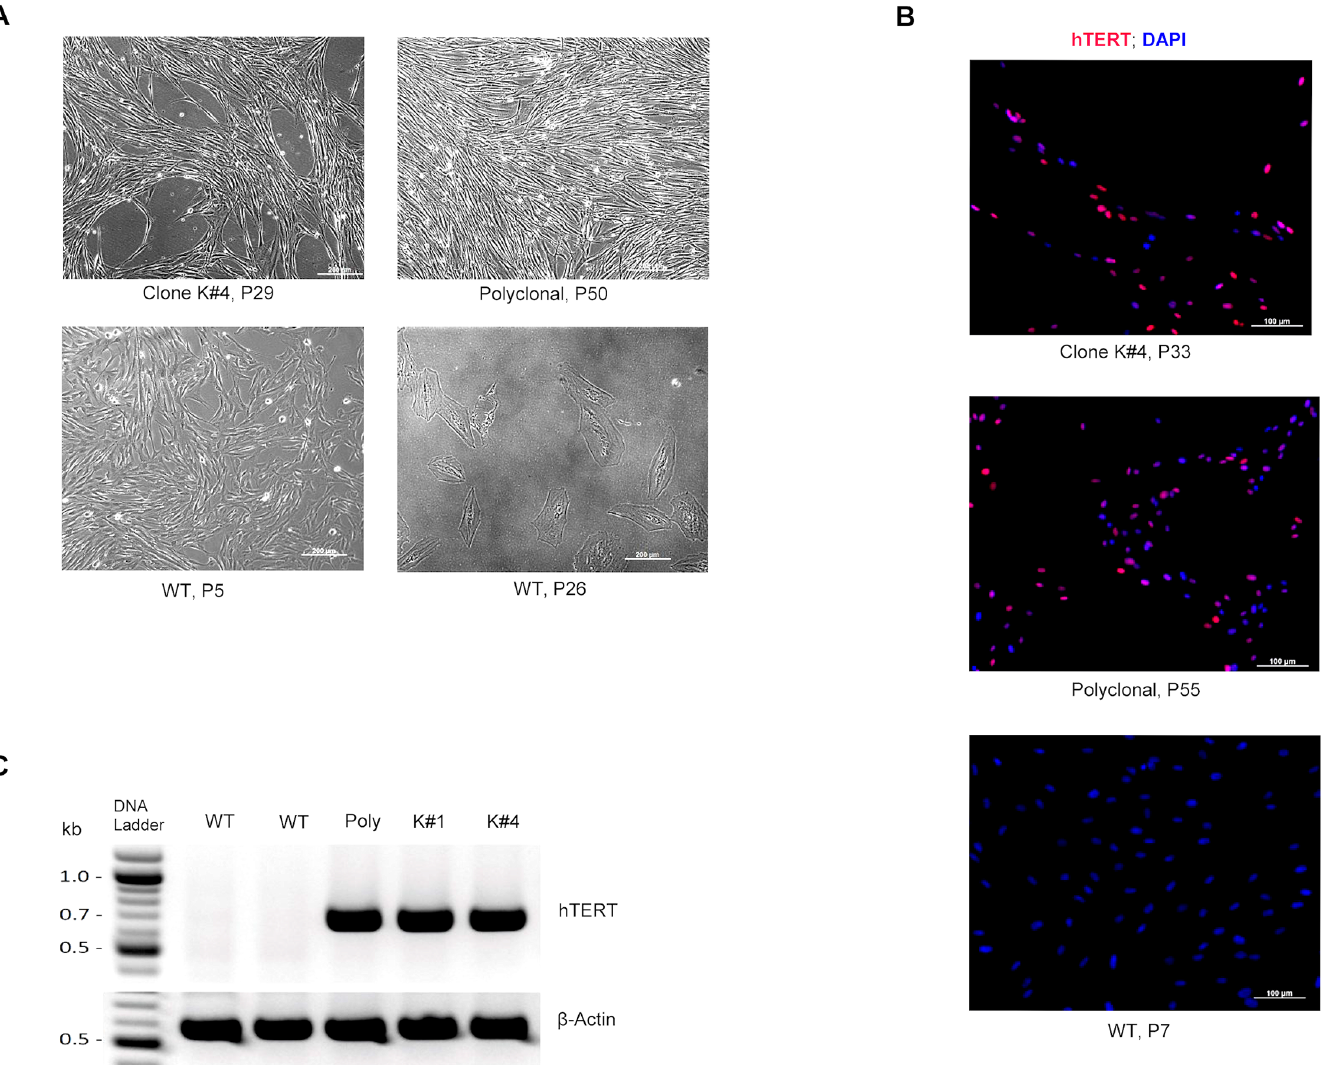
Fig 2. Transgenic hTERT expression. (A) Phase-contrast images of the hTERT- immortalized cell lines (upper row) and wild type (WT) controls (lower row). Monoclonal K#4 and the polyclonal cell line show an elongated, “needle like” morphology when compared to WT fibroblasts. Fibroblasts at P26 show a flat and enlarged morphology typical for cells in senescence. Scale bars = 200 μ m. (B) hTERT immunofluorescence staining of immortalized cell lines. Immortalized cell lines show expected hTERT protein expression (red). No expression was detected in control fibroblasts. Scale bars = 100 μm. (C) RT-PCR for expression of hTERT (upper row) and β -actin (lower row) in one polyclonal (poly), two monoclonal lines (K#1 and K#4), and two control WT fibroblast lines.